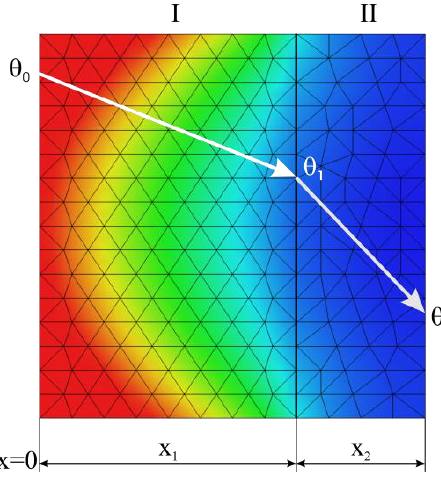
Figure 9. Parallel plane walls.